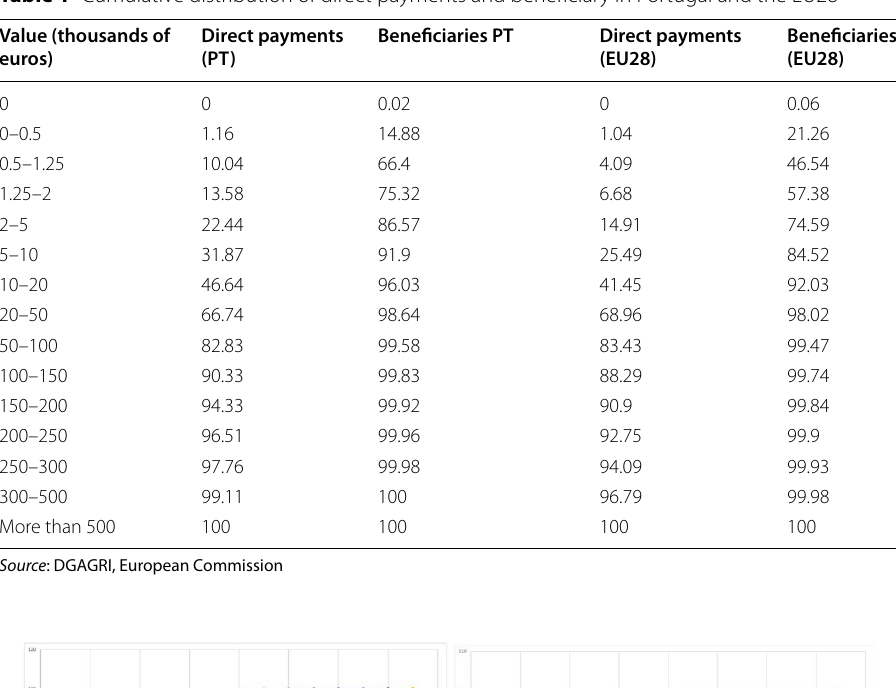
Table 1 Cumulative distribution of direct payments and beneficiary in Portugal and the EU28